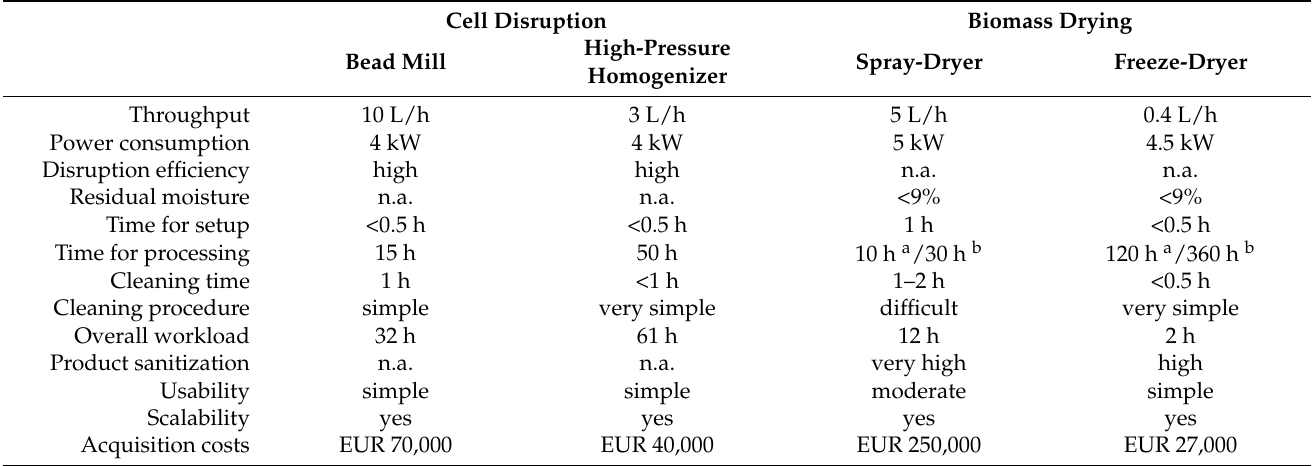
Table 3. Comparison of technical data of the used disruption and drying devices. n.a., not